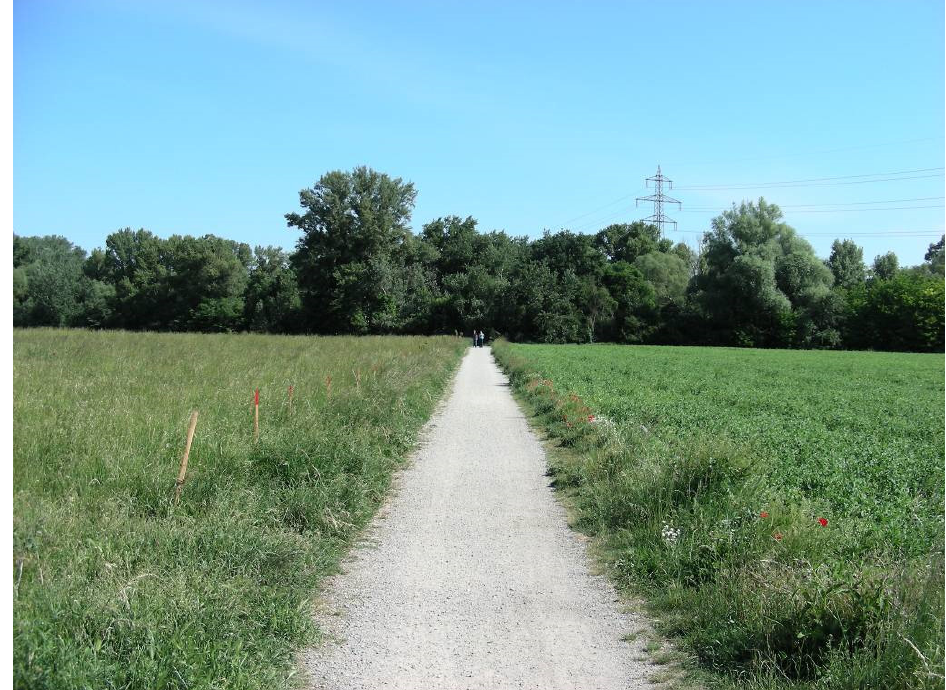
Figure 2. Base photo of a recreational trail in the Lobau used in the construction of the visual choice scenarios.